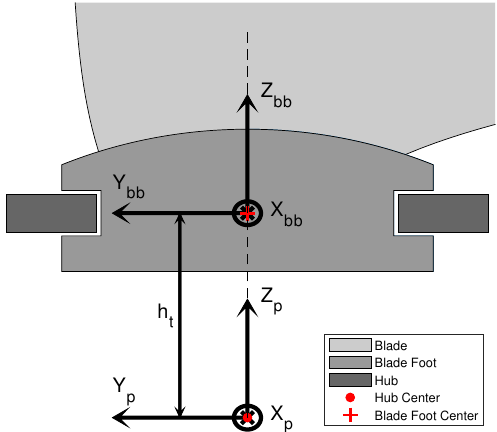
Figure 5. Blade bearing coordinate